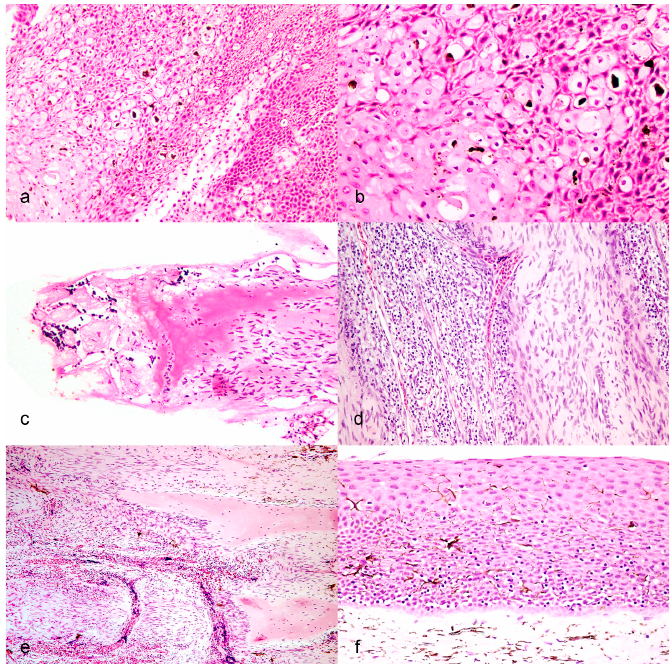
Figure 2 Figure 2. ( a ) Marked ballooning degeneration of the deeper portion of the stratum spinosum of the epidermis. ( b ) Affected cells are enlarged with lightly eosinophilic to clear cytoplasm and their nuclei are swollen with marginated chromatin. ( c ) Transmural necrosis affecting the superficial portion of the lepidotrichia. ( d ) Extensive granulation tissue with dense infiltrates of small lymphocytes separating mineralized spines. ( e ) Segments of mineralized spins were partially lysed, had scalloped edges and were surrounded by proliferating fibroblasts. ( f ) Dense infiltrates of small lymphocytes in the lower portion of the stratum spinosum focally extending into the stratum